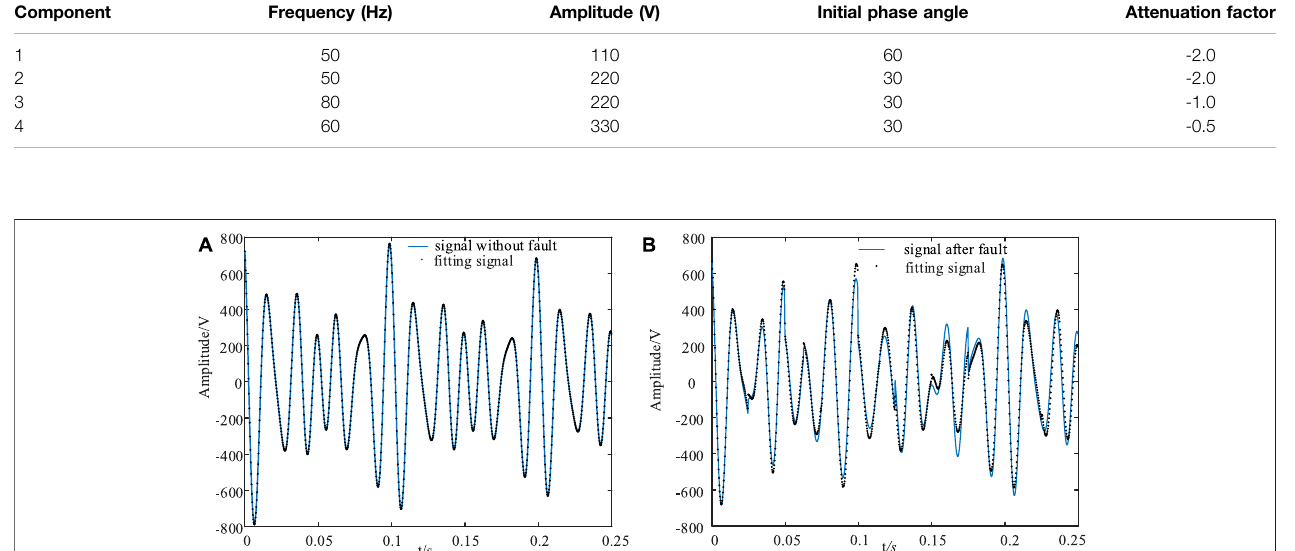
Frontiers in Energy Research |